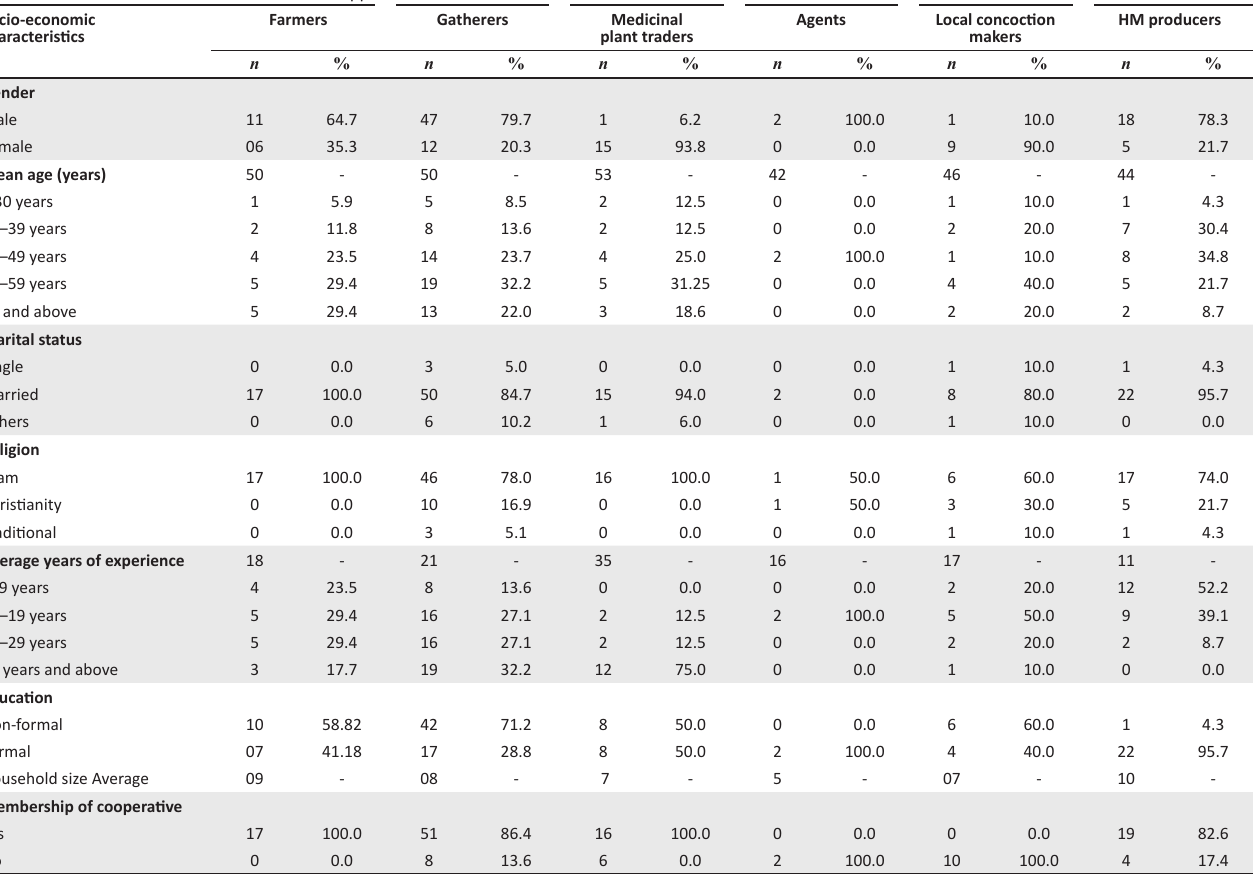
TABLE 1: Socioeconomic characteristics of the supply chain actors. Socio-economic